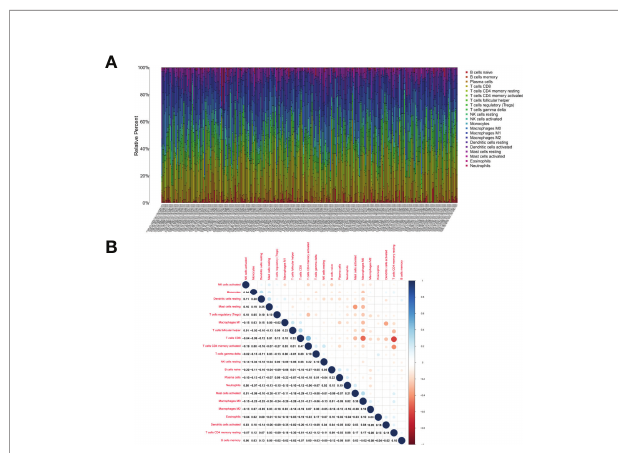
FIGURE 7 | TIC pro fi le in tumor samples and correlation analysis. (A) Barplot showing the proportion of 21 kinds of TICs in CESC tumor samples. Column names of plot were sample ID. (B) Heatmap showing the correlation between 21 kinds of TICs and numeric in each tiny box indicating the p value of correlation between two kinds of cells. The shade of each tiny color box represented corresponding correlation value between two cells, and Pearson coef fi cient was used for signi fi cance test.